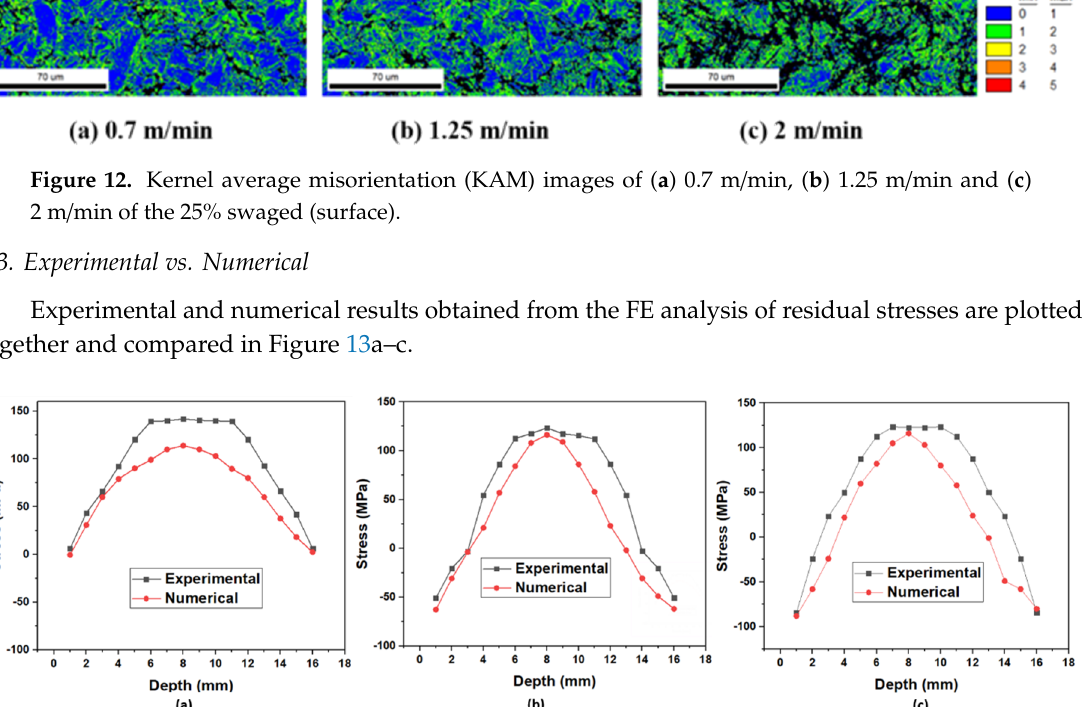
Figure 13. The comparison between experimental residual stresses ( a ) 0.7 m / min, ( b ) 1.25 m / min and ( c ) 2 m / min and the numerically predicted residual stresses for the 25% swaged Zr-4 sample.